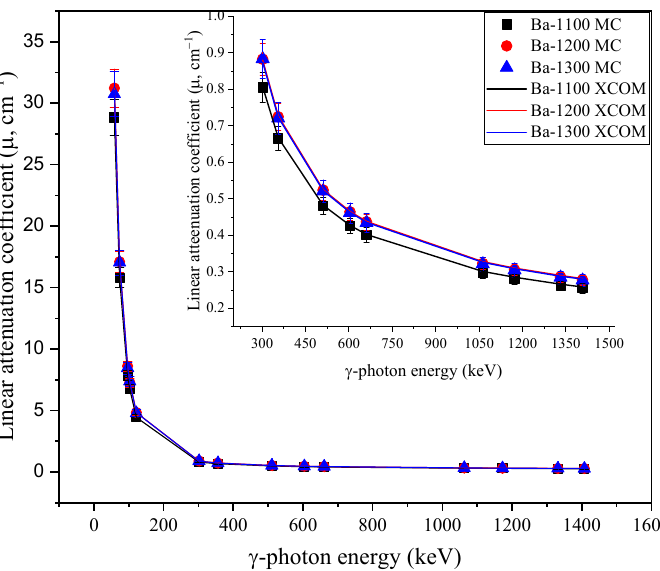
Figure 5. Influence of the incident γ -photon energy on the µ values of the fabricated ceramic sam ‐ ples.